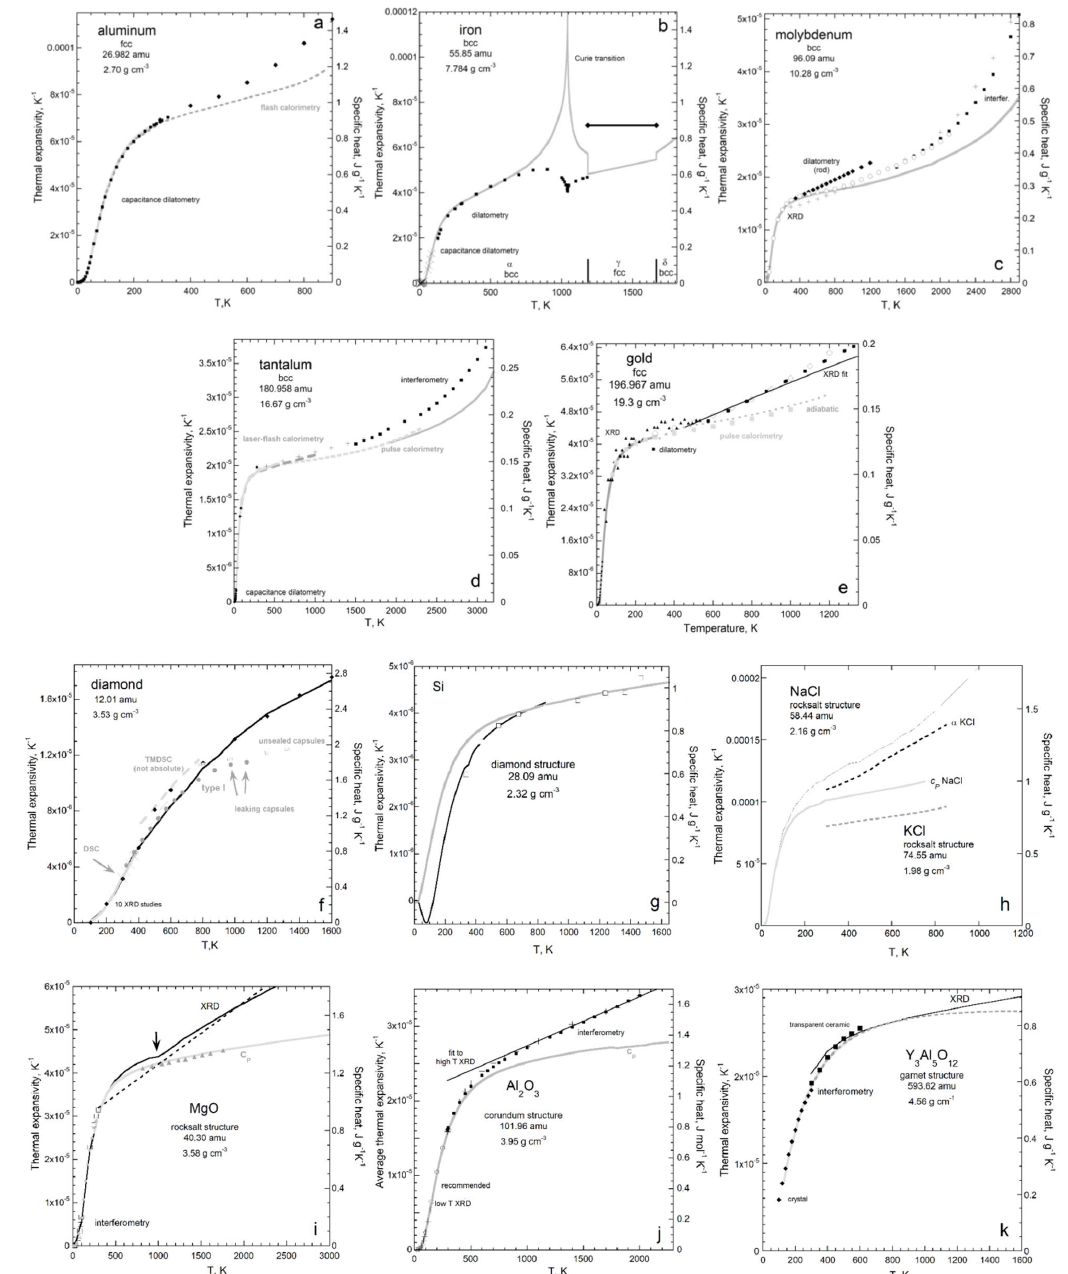
Figure A1. Comparison of properties describing the response of solids to heat additions. Left axis: black curves and points = volumetric thermal expansivity. Right axis: grey curves and points = specific heat. Scales were chosen to best match α and c P at cryogenic T . Properties are at ambient conditions, taken from various compilations. ( a ) Aluminum. Squares = α [97]. Diamonds = rec- ommended α [37]. Grey solid curve = c P compiled and evaluated by Desai [98]. Dashed = laser-flash calorimetry [99]. ( b ) Iron. Thick vertical bars mark structural phase transitions. X = capacitance measurements of α [100]. Squares = dilatometry [101]. Diamonds = recommended c P [39]. Grey curve = c P compiled and evaluated by [102]. ( c ) Molybdenum. + = recommended fit to α [37]. Circles = XRD results compiled and evaluated by Wang and Reeber [103]. Squares = transient interferom- etry [104]. Diamond = dilatometry data [105]. Grey curve = c P compiled and evaluated [106]. ( d ) Tantalum. Diamonds = capacitance measurements of α [107]. + = fit to recommended values [37,96] by [94]. Squares = transient interferometry [108]. Light grey line = cryogenic calorimetry data [109]. Grey long dashes = laser flash calorimetry [110]. Grey short dashes = pulse calorimetry [111]. Dark grey line = pulse calorimetry [112]. ( e ) Gold. Black dots = tabulated α [113]. Triangles, α obtained by differentiating tabulated volumes of Pamato et al. [114]. Thin line = α from 2 nd order polynomial fit to V [114]. Open diamonds = recommended fit to α [94]. Squares = dilatometry and XRD data from Suh et al. [105]. Thick grey line = raw c P data [115]. Dotted line = mid-range of adiabatic calorimetry data [116]. Grey squares = pulse calorimetry [117]. ( f ) Diamond. Black diamonds = α from Slack and Bartram [117], who combined 10 XRD studies of large natural crystals. Thin curve = recommended α [37]. Solid grey curve = c P [118]. X = DSC [119]. Dots = drop calorimetry of Victor [120], who stated air leakage occurred for the highest T points. Square with cross = Weber [121], who heated his samples in air. Dashed line = modulated DSC data [122], which are not absolute. ( g ) Si. Black curve = recommended α [123]. Squares = single-crystal α [124]. Grey curve = c P compiled and evaluated [102]. ( h ) Alkali halides. Solid lines = NaCl data: black = α [80]; grey = c P [81]. Dashed lines = com- piled KCl data [54]. ( i ) MgO. Solid curve, α as tabulated in [125] which has an inflection point (ar- row) at 1000K instead of a sway. The kink may be exaggerated, due to low and high T segments probing crystals and ceramics, respectively. Open squares = cryogenic data [126,127]. Short dashes = 2 nd order polynomial fit to tabulated XRD data [93], acquired using an Ir wire heater. Grey dots = c P from [128]; triangles from [129], obtained by differentiating heat content; solid = Chase’s [130] review, where the high T trend is an extrapolation. ( j ) Al 2 O 3 . Circle = α from powder XRD compiled and evaluated [131]. + = α compiled and evaluated [132]. Thin line = linear description of high T powder XRD [93]. Squares = single-crystal interferometry and twin telemicroscope measurements [133]. Grey curve = c P compiled and evaluated by [134]. ( k ) Yttrium aluminum garnet. Diamonds =